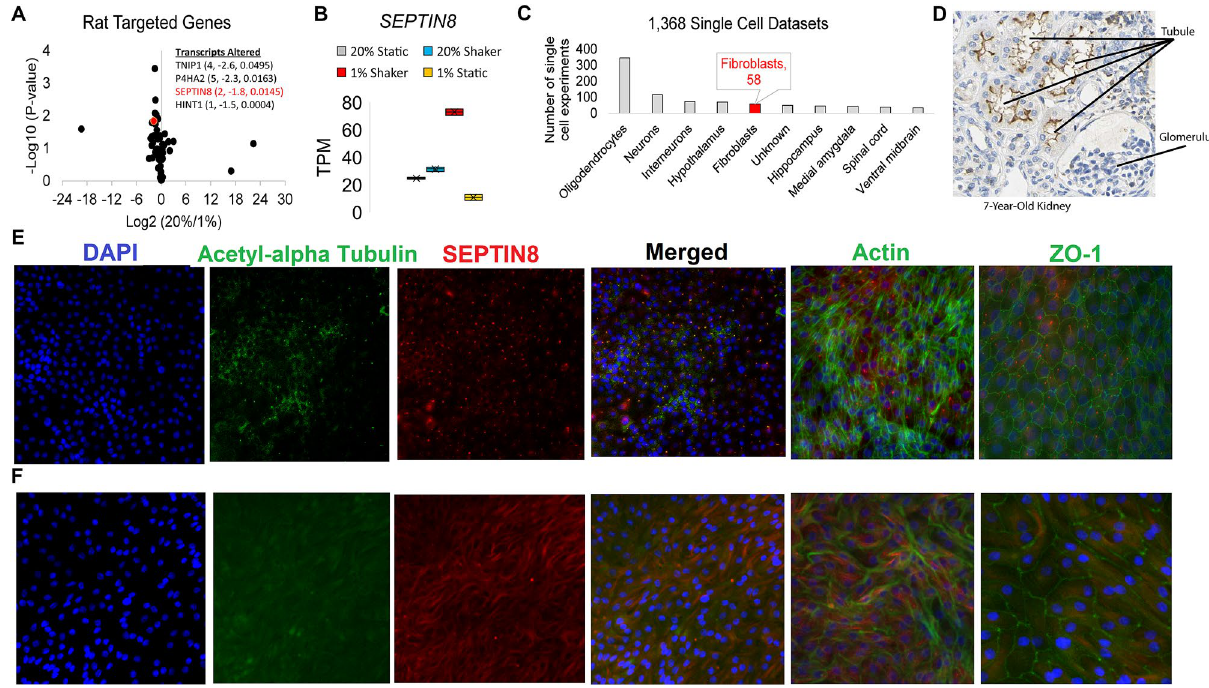
Figure 5. Data implicating Sept8/ SEPTIN8 in the human tubule hypoxia cell culture model. ( A ) RNAseq values of genes within rat LD block within the RPTEC TERT1 normoxic vs hypoxic conditions. Genes on the right are significant genes. ( B ) TPM values in each of the RNAseq groups for SEPTIN8 in the RPTEC TERT1 cells. ( C ) Expression of SEPTIN8 in single cell datasets (human and mouse). ( D ) Immunohistochemistry from the Human Protein Altas (modified from www.prote inatl as.org/ENSG0 00001 64402 -SEPT8 /tissu e/kidne y 42 ) for SEPTIN8 using HPA005665 antibody. Labels are added for tubules and glomerulus. ( E ) Immunofluorescence of SEPTIN8 (red) with acetyl-alpha tubulin, actin, or ZO-1 (green) as labeled. SEPTIN8 localizes with